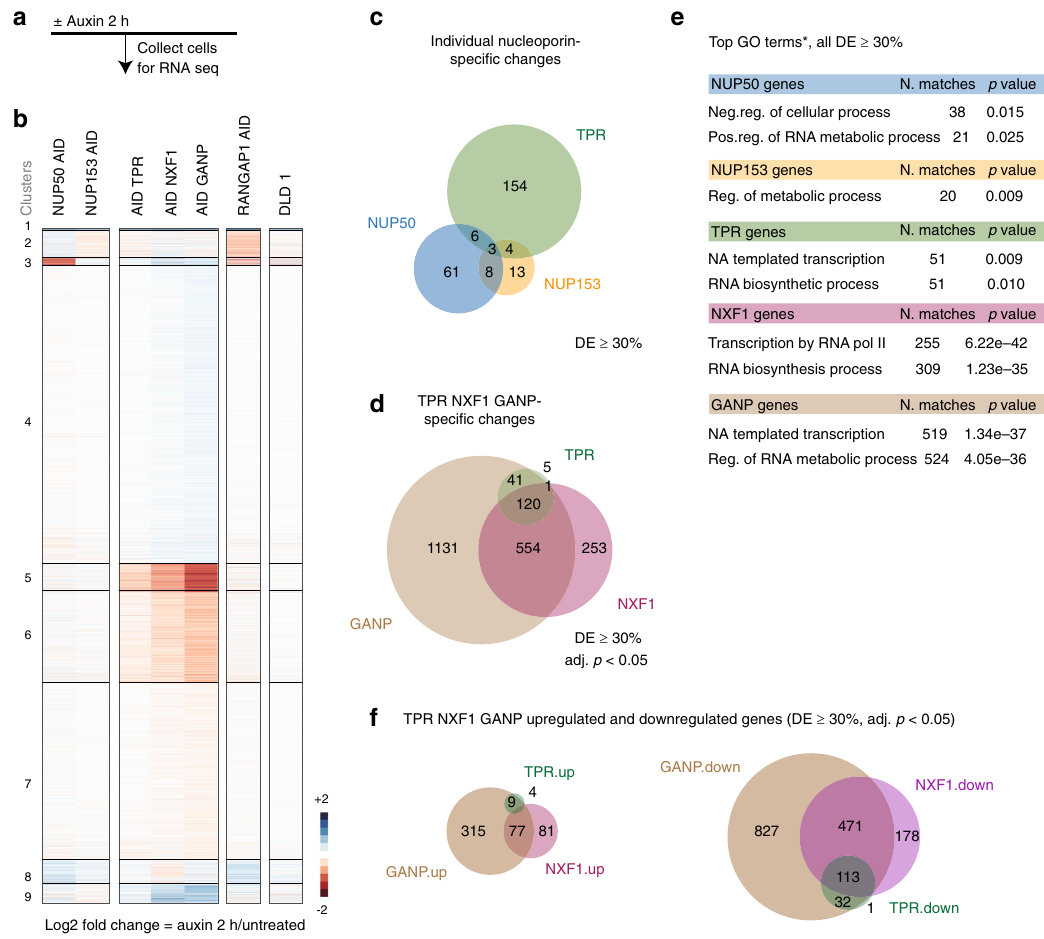
Fig. 2 Loss of TPR leads to rapid changes in mRNA abundance. a , b A scheme of the experiment and heatmaps of unsupervised k -means clustering of differentially expressed genes 2 h after auxin treatment of cells expressing corresponding AID-tagged proteins. DLD-1 parental DLD-1 cells treated with auxin. Three independent biological replicates were used to perform RNA-seq of the indicated cell lines. c A Venn diagram representing the number of RNAs that showed signi fi cant change (both upregulation and downregulation) upon NUP50 (blue), NUP153 (yellow), and TPR (green) loss. d A Venn diagram representing the overlaps among signi fi cantly regulated transcripts upon TPR, NXF1 (purple), or GANP (brown) depletion ( p value <2.3e − 117, hypergeometric distribution test). e Top GO terms (*Biological Process, HumanMine v5.1 2018) of differentially expressed (DE) RNAs upon loss of the indicated nucleoporins ( c ), NXF1, and GANP ( d ). All DE RNAs ( c , d ) are log2FC > 30%, adj. p value <0.05, Wald test. f A Venn diagram representing the overlaps between signi fi cantly upregulated or downregulated transcripts upon TPR, NXF1, or GANP loss. Note that most of the TPR/NXF1/GANP- dependent RNAs are downregulated. Neg. negative, Pos. positive, Reg. regulation, NA Nucleic Acid, GO Gene Ontology, FC fold